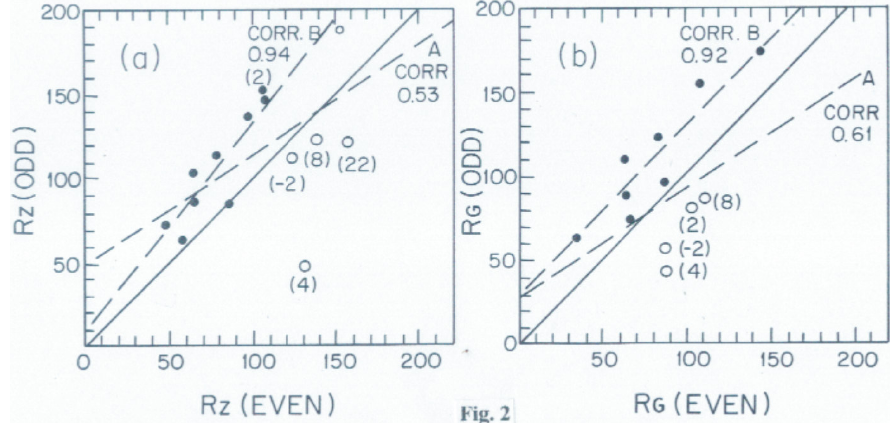
Fig. 2. (a) Plots of Rz (max) of even cycles (abscissa) versus Rz (max) of odd cycles (ordinate).The full line is a 45 ◦ line, implying equal values for even and odd cycles. Points above the line (shown by dots) are when G-O rule proved correct. Points below (shown by circles) indicate G-O rule failures. The dashed regression line A is for all the points (dots and circles). The dashed regression line B is for all the dots only (i.e. excluding the circles). (b) Similar plots for R G (max).